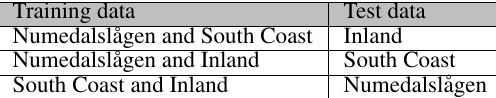
Table 3. Training and test data used to evaluate the classifier.